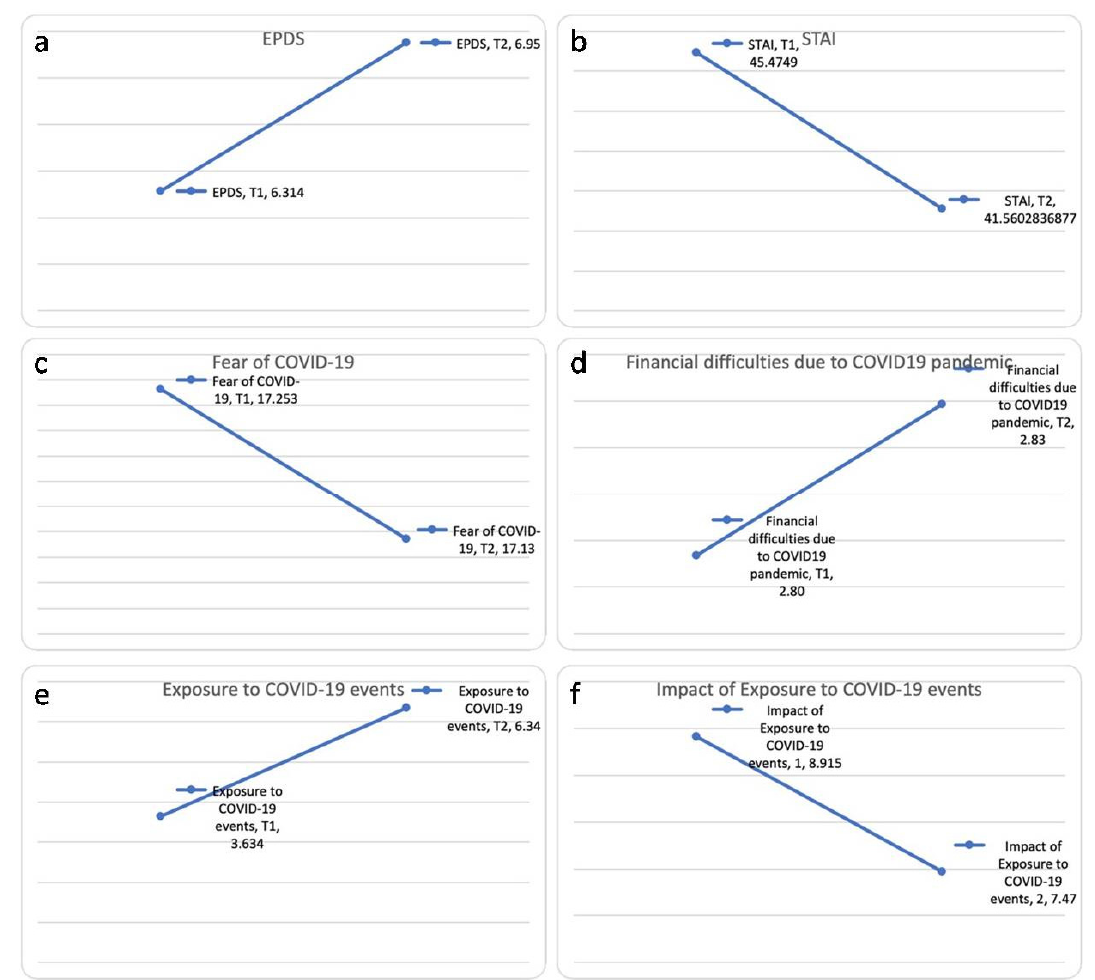
Figure 2. The difference between the EPDS scores ( a ), STAI scores ( b ), fear of COVID-19 ( c ), financial difficulties due to COVID-19 pandemic ( d ), exposure to COVID-19 events ( e ), and impact of exposure to COVID-19 events ( f ) between T1 and T2.